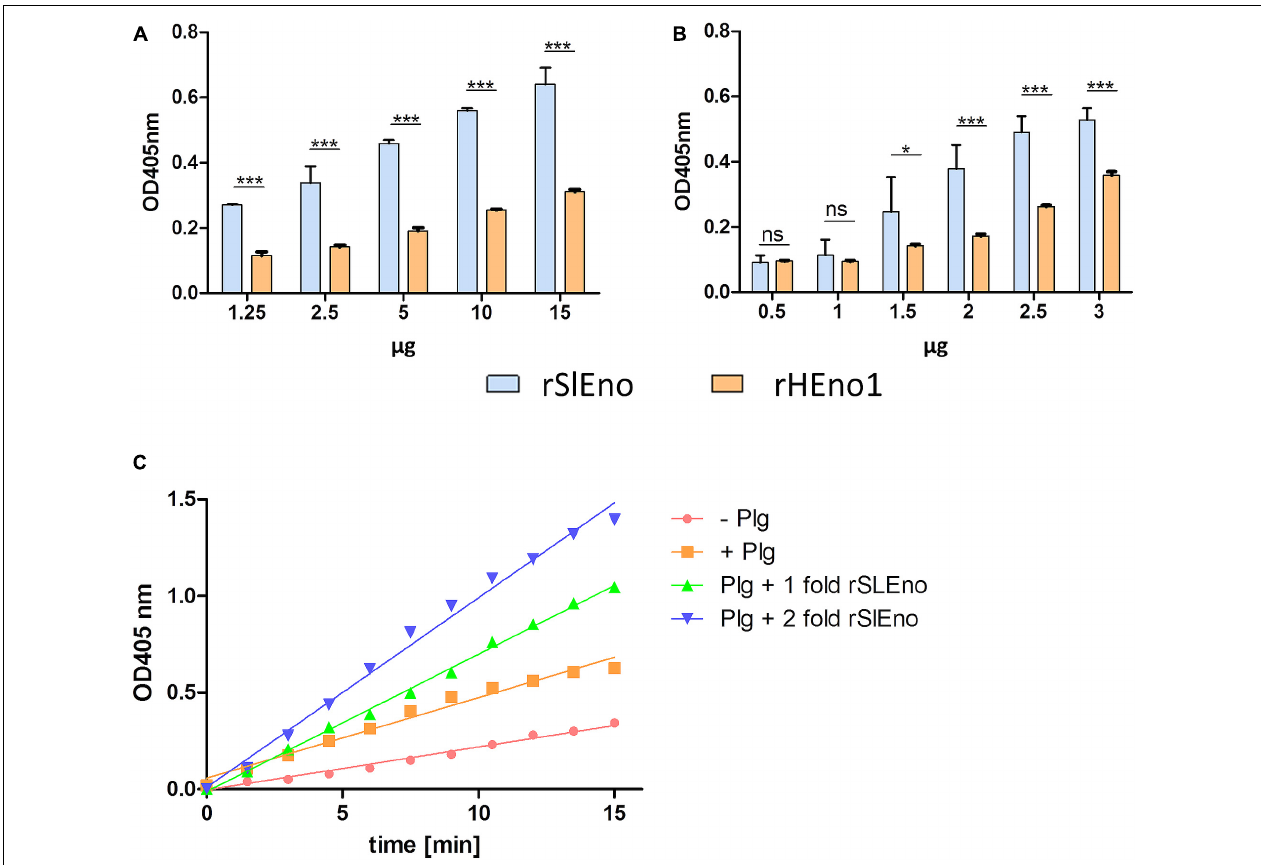
FIGURE 7 | Binding of rSlEno and rHEno1 to plasminogen (A,B) and conversion of plasminogen into plasmin (C) by rSlEno. (A,B) Either 1 µ g of rSlEno or rHEno1 (A) or Plg (B) was immobilized on microtiter plates and incubated with increasing concentrations of Plg (A) or rSlEno and rHEno1 (B) . Plg was detected by anti-Plg Abs (A) , rSlEno and rHEno1 by anti-SlEno or anti-HEno polyclonal Abs (B) . Results are shown as the mean of three independent experiments with the standard deviation (SD). Statistical analyses were performed using two-way ANOVA with Bonferroni multiple comparisons post-test (* p < 0.05, *** p < 0.001, ns, not significant). (C) rSlEno enhanced the conversion of plasminogen (Plg) into plasmin (Pln) in the presence of tissue tPA. The reaction progress is measurable by the presence of the chromogenic substrate D-valyl-L-lysyl-p-nitroaniline